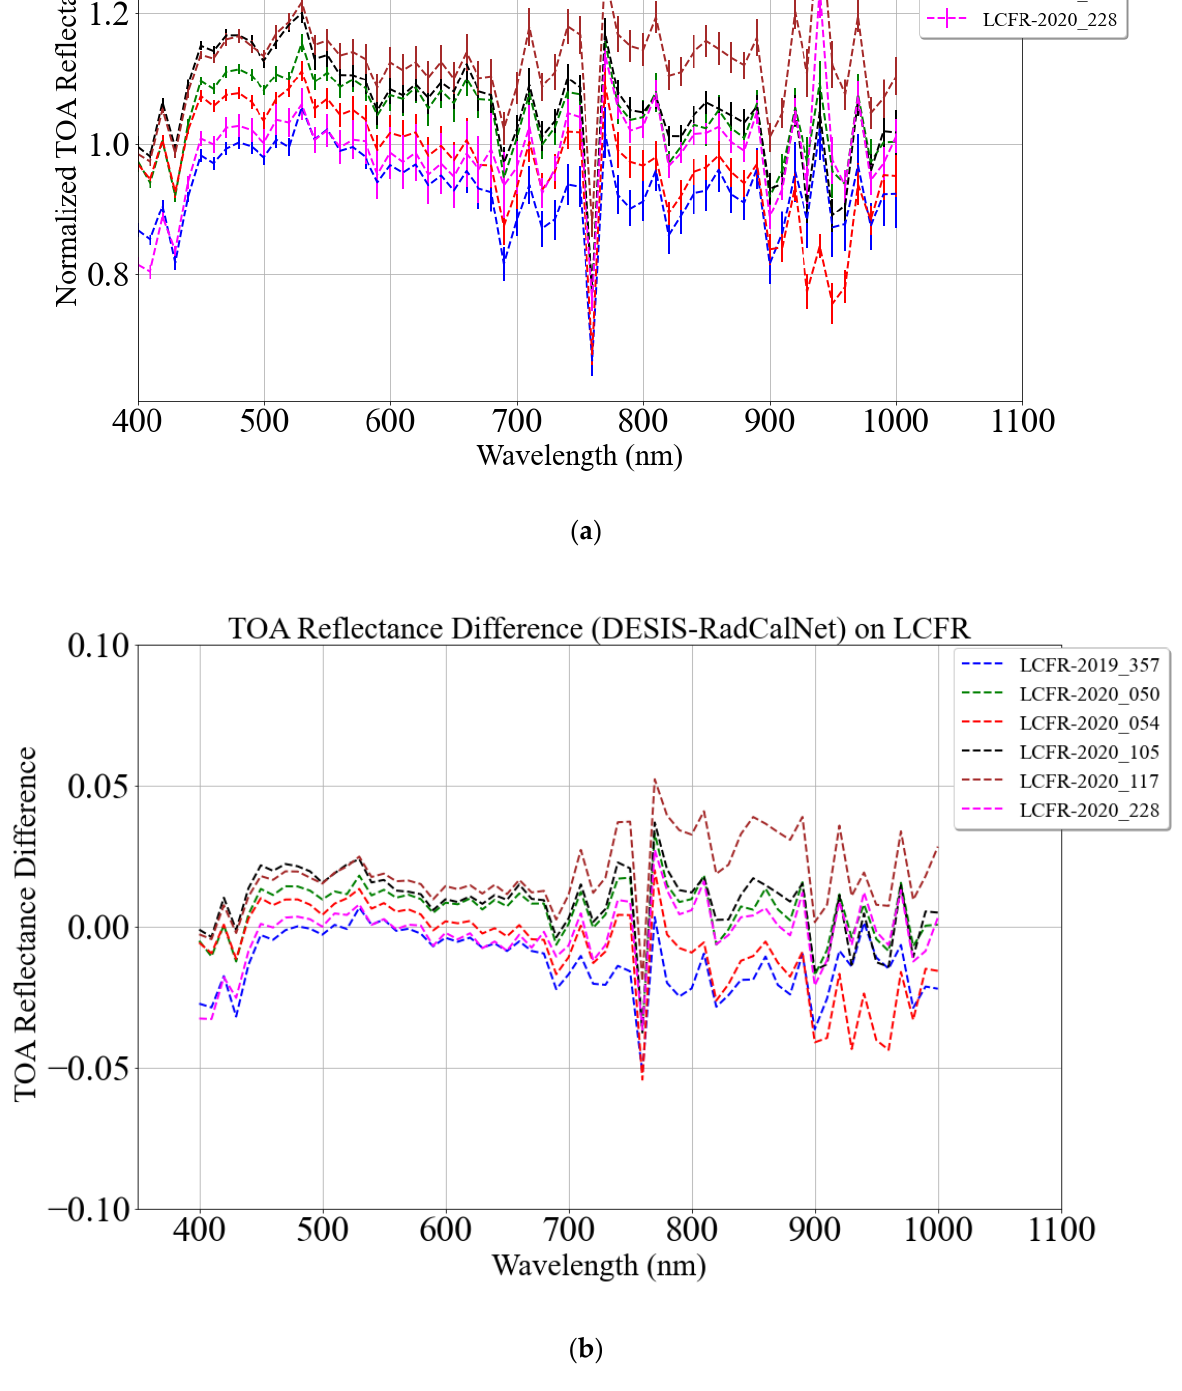
Figure 15. DESIS normalized TOA reflectance on LCFR ( a ). Absolute TOA difference between DESIS and RadCalNet TOA reflectance ( b